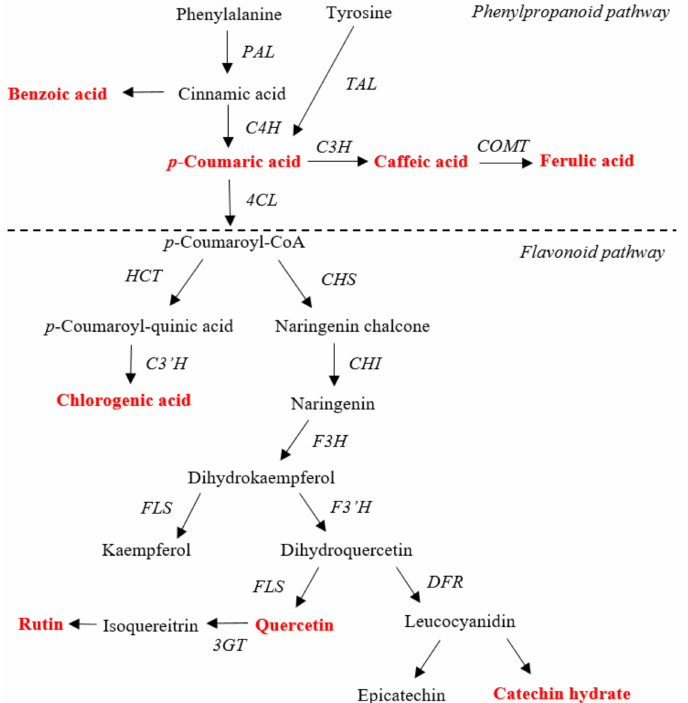
Figure 1. Schematic representation of phenylpropanoid and flavonoid biosynthetic pathways. Red bold color indicates the phenylpropanoids and flavonoids measured in this study. PAL ,